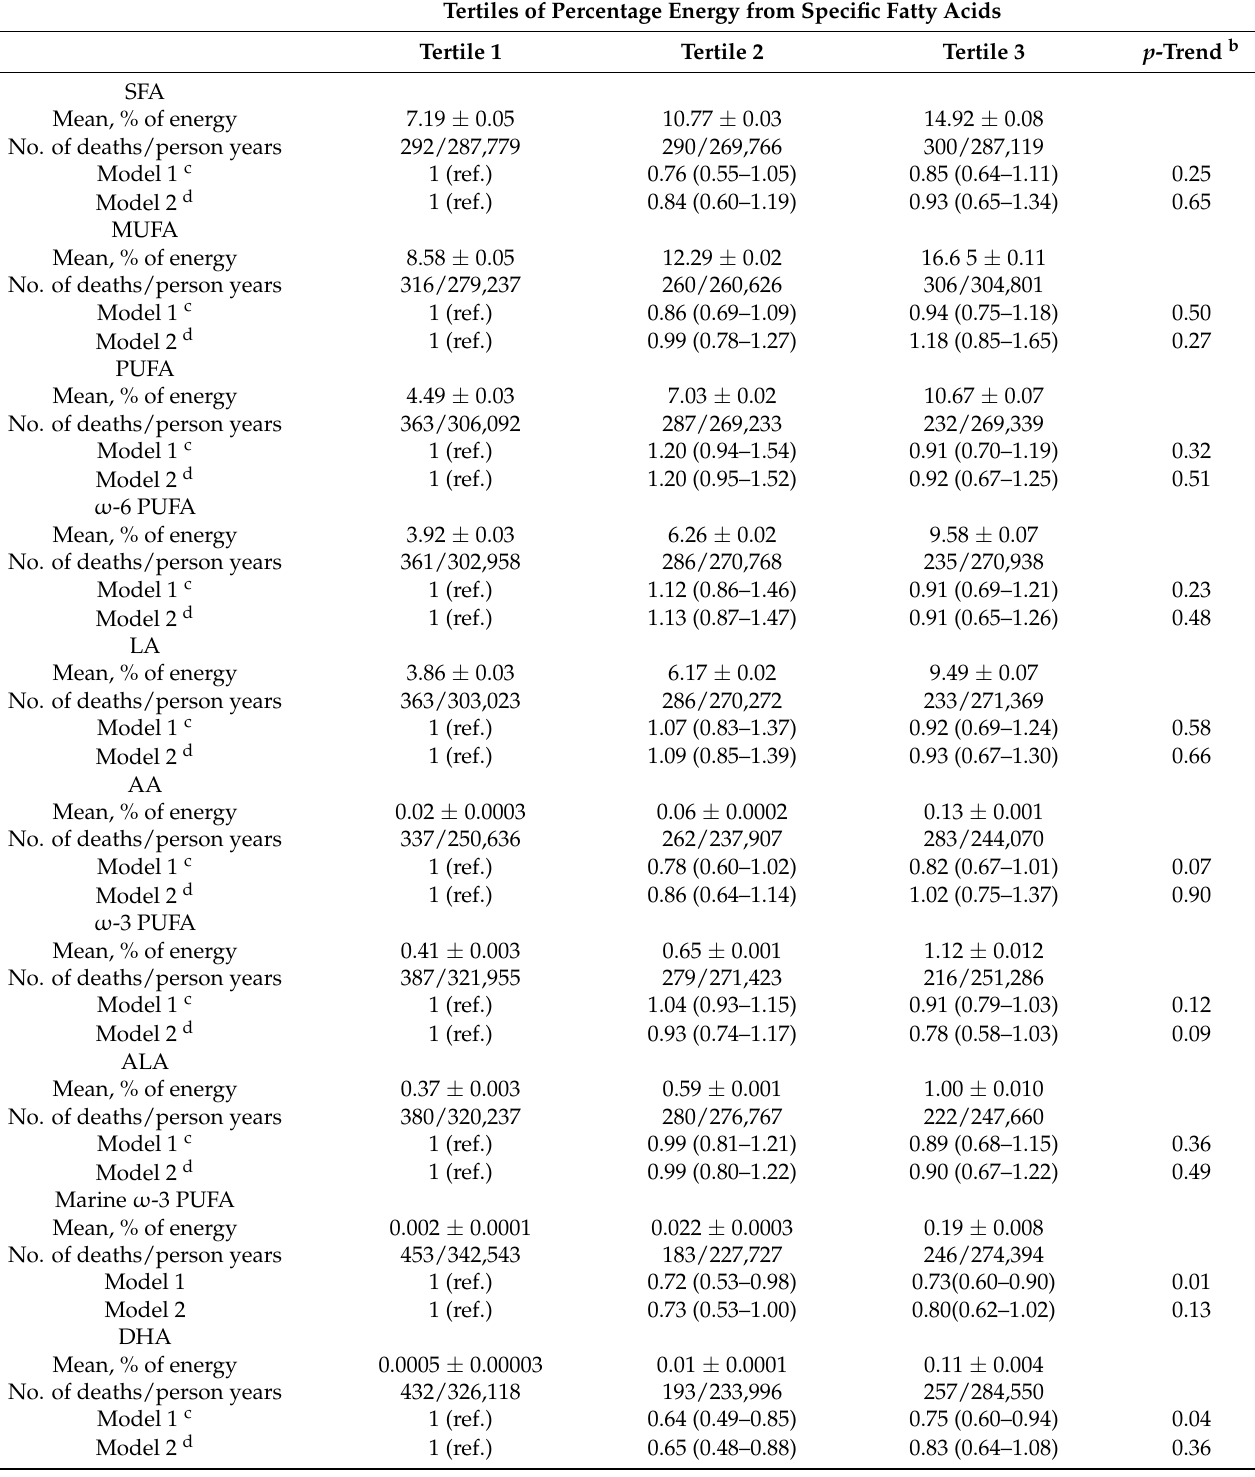
Table 3. Associations of specific fatty acids with CVD mortality among patients with CMD a . Tertiles of Percentage Energy from Specific Fatty Acids Tertile 1 Tertile